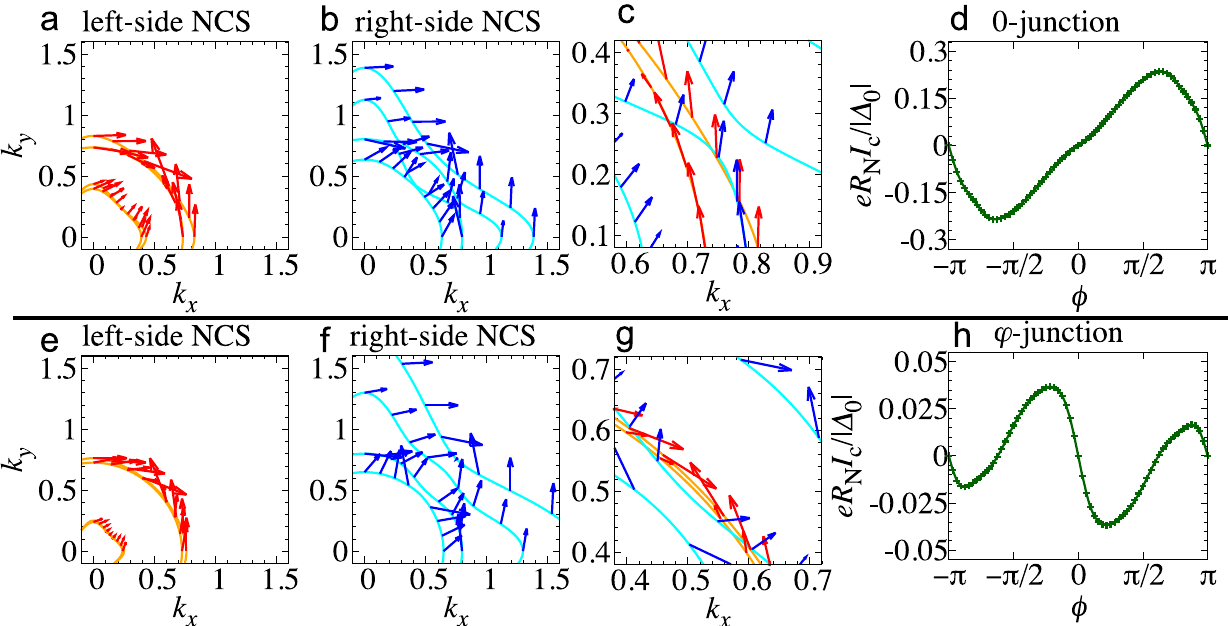
Fig. 2 Current phase relation dependence on the orientation of the spin-triplet d -vector in the two sides of the junction. a – c Indicate the d -vector orientation along the four Fermi lines on the left (L) and right (R) sides of the junction with a resulting current-phase relation d marked by a 0-Josephson coupling. d -vector along the four Fermi lines at a ( λ SOL / t , α ORL / t , μ L / t ) = (0.06, 0.05, 0.00) and b ( λ SOR / t , α ORR / t , μ L / t ) = (0.10, 0.15, 0.10) in the two NCS forming the junction. c Zoom-in of the d -vector pattern for the electronic con fi gurations in a and b around the overlapping points of the Fermi lines. d Current phase relation evaluated by assuming the a and b electronic con fi gurations on the two sides of the Josephson junction at T / T c = 0.025, indicating a 0-type Josephson phase. d -vector along the four Fermi lines for different electronic parameters: e left-side NCS ( λ SOL / t , α ORL / t , μ L / t ) = (0.02, 0.05, 0.00) and f right-side NCS ( λ SOR / t , α ORR / t , μ R / t ) = (0.20, 0.30, 0.10). g Zoom-in view of e and f nearby the overlapping points of the left- and right-side Fermi lines. h Current phase relation assuming the e and f electronic con fi gurations on the two sides of the Josephson junction at T / T c = 0.025. The computation of the current phase relations in d and h has been performed by means of the recursive Green's function